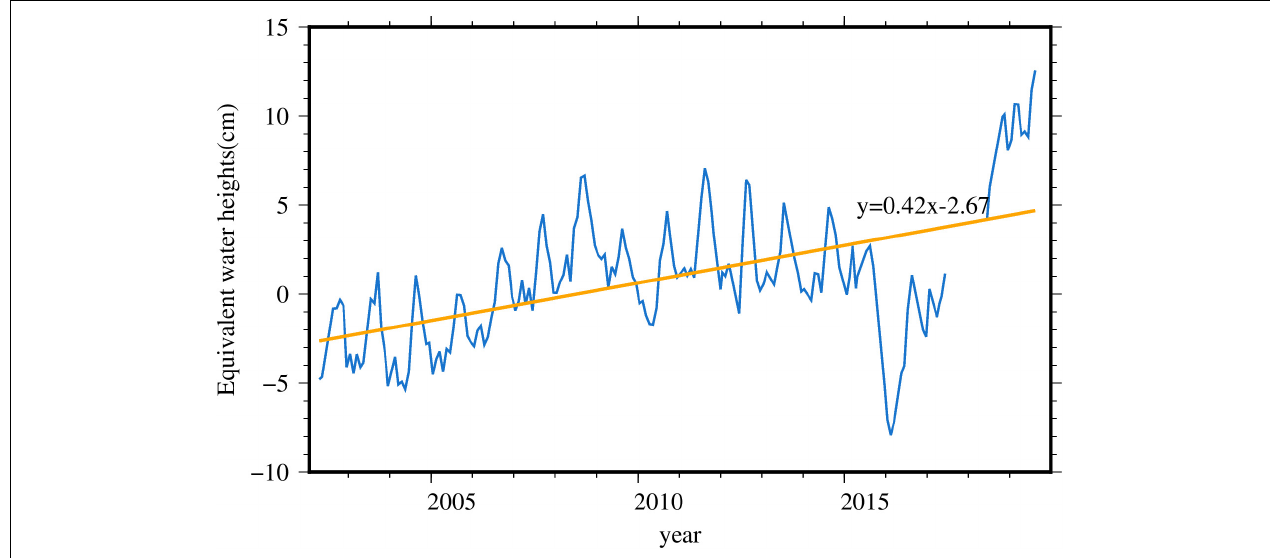
FIGURE 10 | EWH time